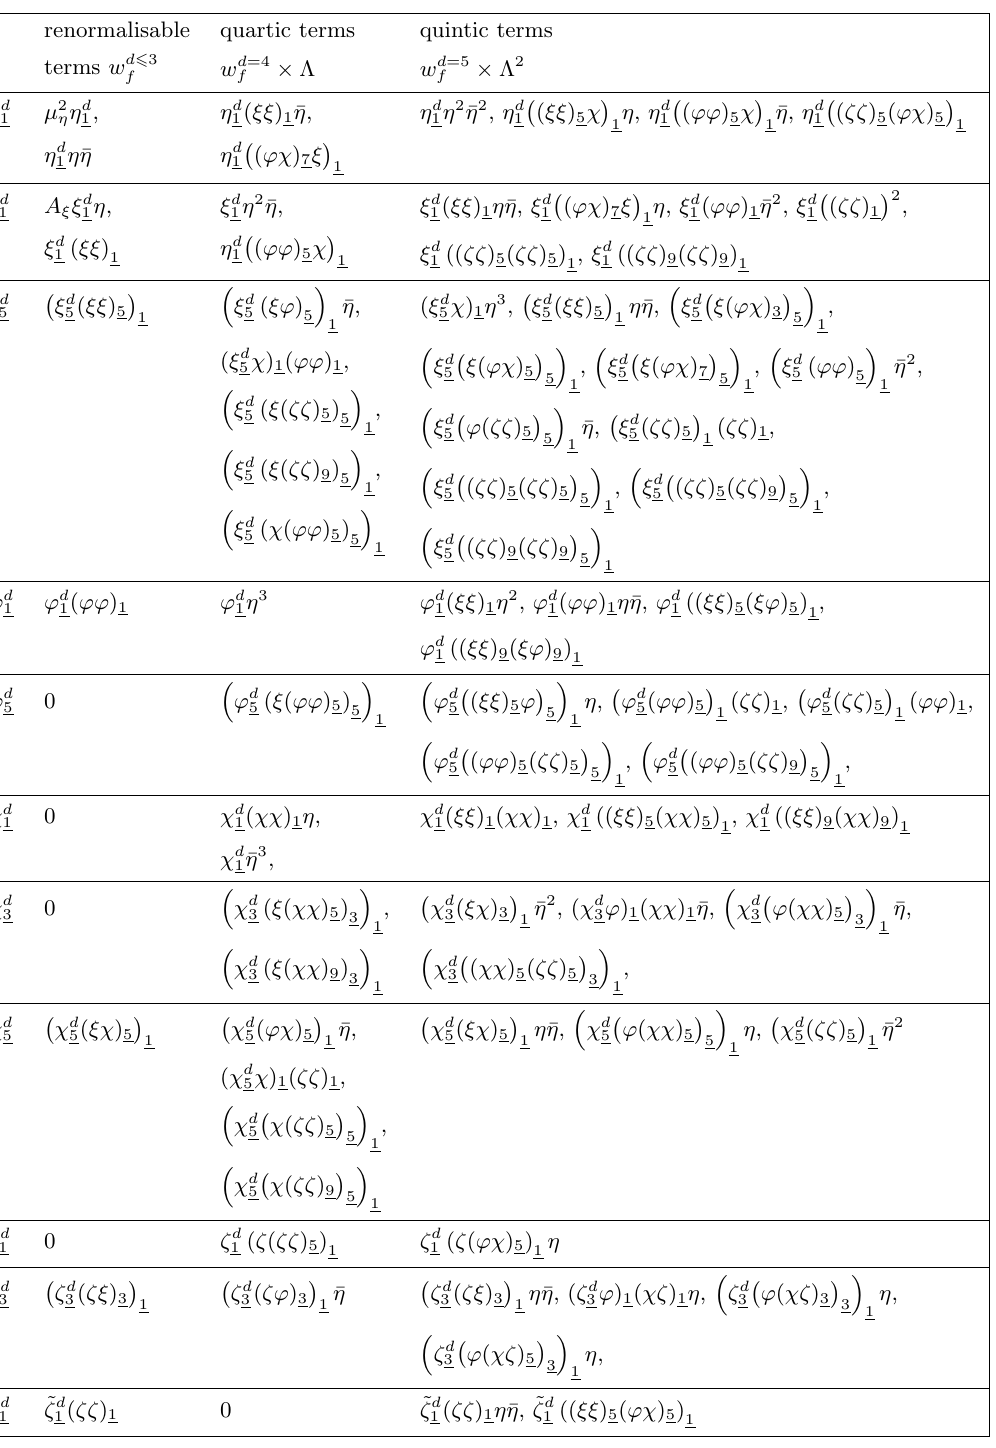
Table 4 . All terms up to quintic couplings in the (cid:13)avon superpotential allowed by the (cid:13)avour in the